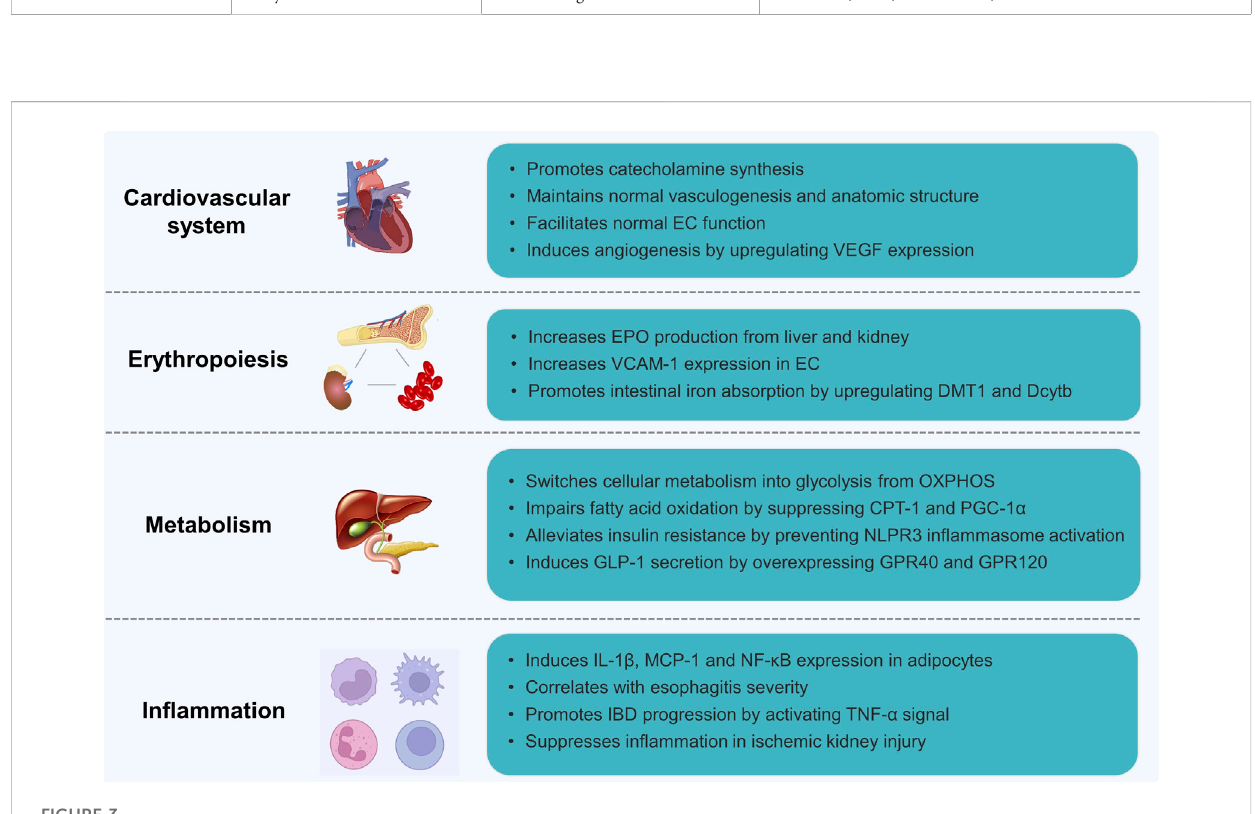
FIGURE 3 The biological functions of